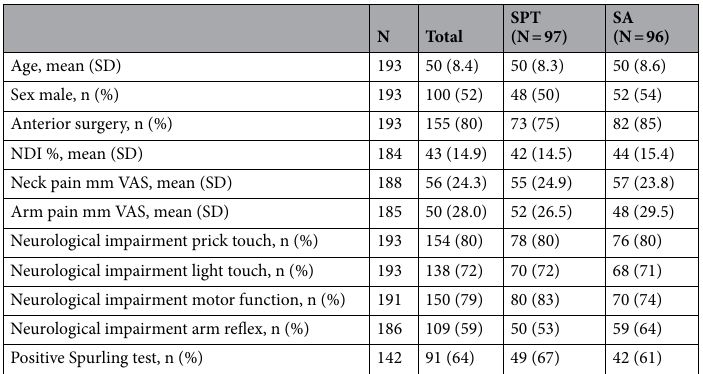
Table 1. Background variables for participants with cervical radiculopathy who underwent surgery and postoperative rehabilitation and were included in the secondary analysis of postoperative neurological outcomes. Results are presented with mean value and standard deviation (SD) or number (n) and percentage